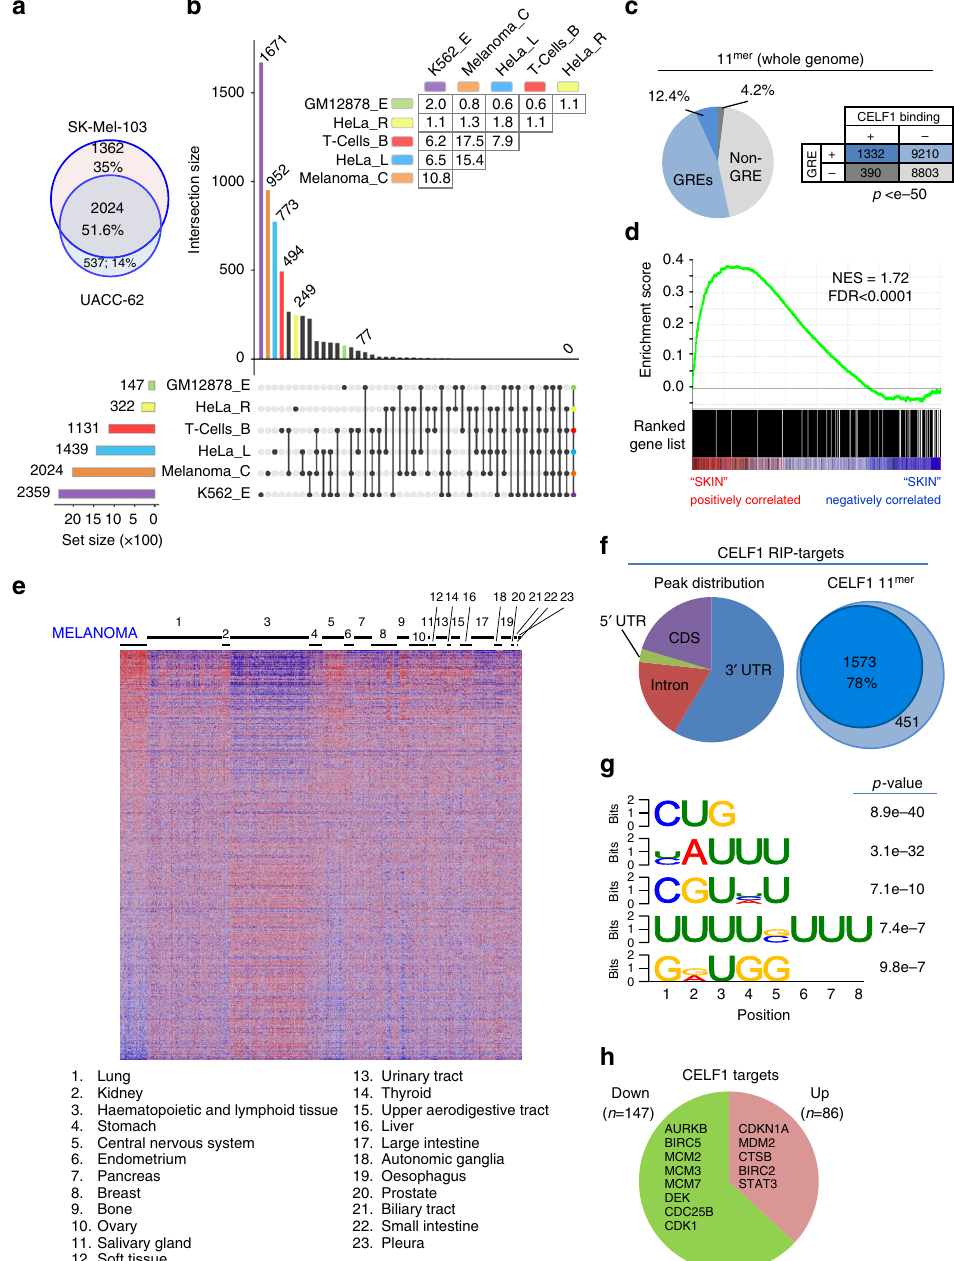
Fig. 3 CELF1-bound targets in melanoma cells differ from other systems. a Venn diagram showing the numbers and corresponding overlap (%) of RNA immunoprecipitated transcripts. See Supplementary Fig. 1 and Supplementary Data 7 for additional information on experimental procedures and statistical analyses, respectively. b UpSet plot revealing the minimal overlap between the CELF1-RNA interactome in melanoma cells relative to the fi ve publicly available cancer data sets. Each study is color coded. The horizontal bars summarize the number of genes. Circles and vertical lines in the x -axis mark the corresponding data sets being compared (the right-most data corresponding to the overlap of the six data sets). The vertical bar chart ( y -axis) indicates the number of genes identi fi ed for each comparison. The number of unique genes for each data set are indicated on top of the corresponding bar. The inset table shows the overlap percentage in one-to-one comparisons. c Percentage of human-coding genes containing (blue) or lacking (gray) in their 3 ′ UTRs CELF1 consensus GREs (UGUUUGUUUGU and UGUGUGUGUGU, two mismatches allowed). The fraction of genes found by RIP-Seq to be bound by CELF1 in melanoma is indicated in darker colors. The contingency table summarizes the number of genes in each category. d Enrichment score plot of “ melanoma-only ” CELF1-bound targets across 24 tumor types of the CCLE ( n = 54 and n = 752 melanoma and other cancers, respectively). NES normalized enrichment score. FDR false discovery rate. e Heatmap plot to visualize enrichment of CELF1-RIP targets in melanoma vs. the rest of tumors. f Localization of the melanoma CELF1 targets according to the peak density of the RIP-Seq analysis de fi ned by the Piranha software. The Venn diagrams represent the fraction of genes with the 11mer GREs of c (see Supplementary Data 4 for detail). g Enriched sequences from the melanoma CELF1 RIP-Seq data de fi ned by the DREME algorithm ( p < 0.005). h Fraction of CELF1 targets (identi fi ed by RIP-Seq) found by HJAY to be downregulated (green) or upregulated (pink) in CELF1 depleted SK-Mel-103 and UACC-62 cells relative to the control transduced cells. Representative genes with roles in cell cycle progression and cell survival are